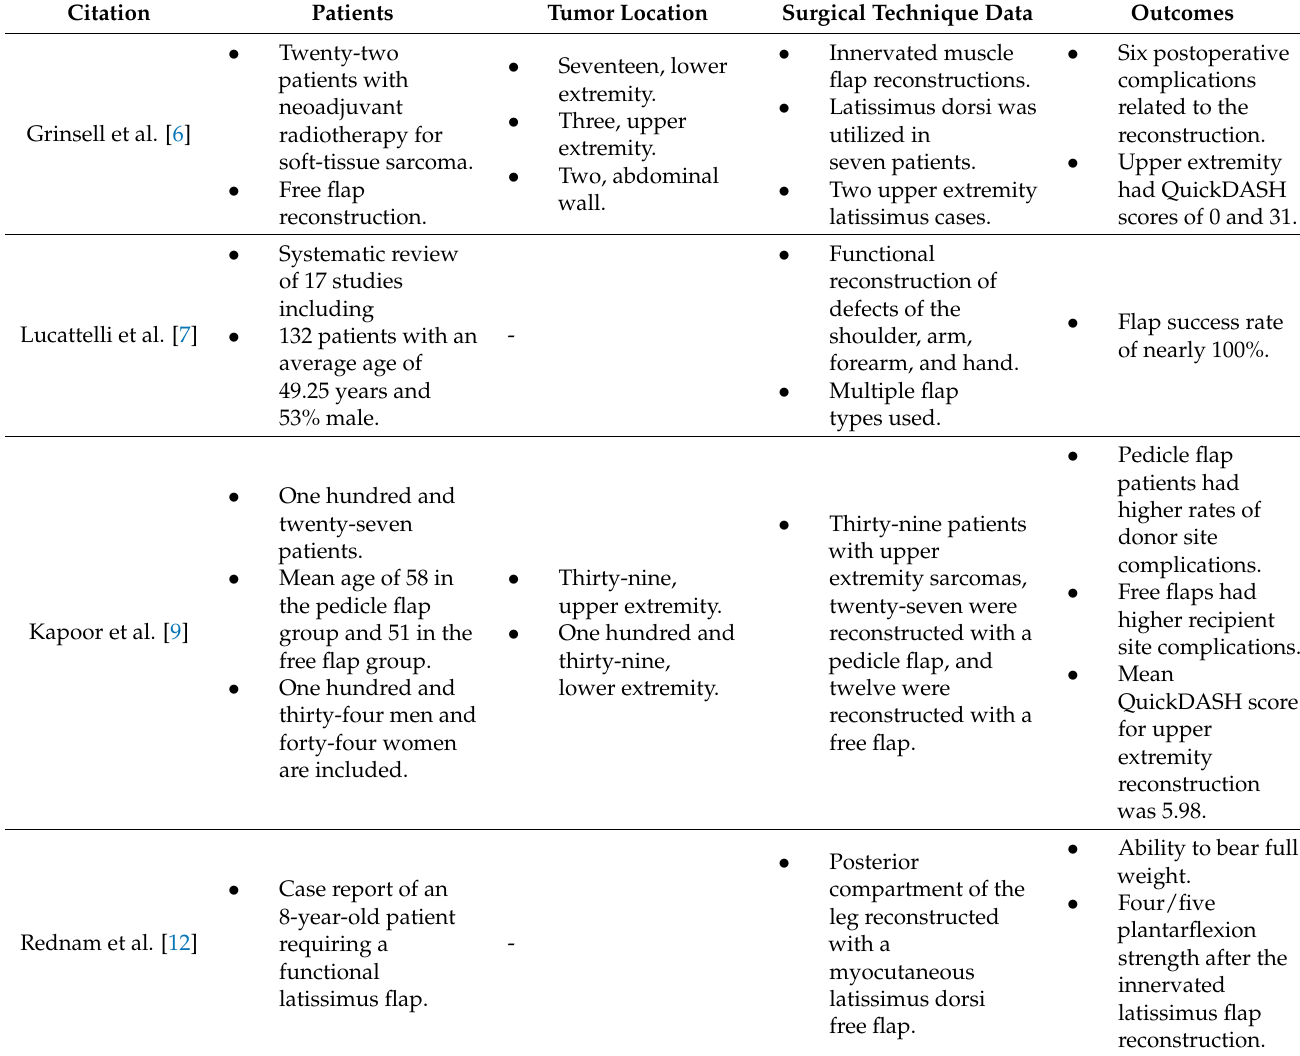
Table 3. Previous series examining the use of latissimus flaps for sarcoma